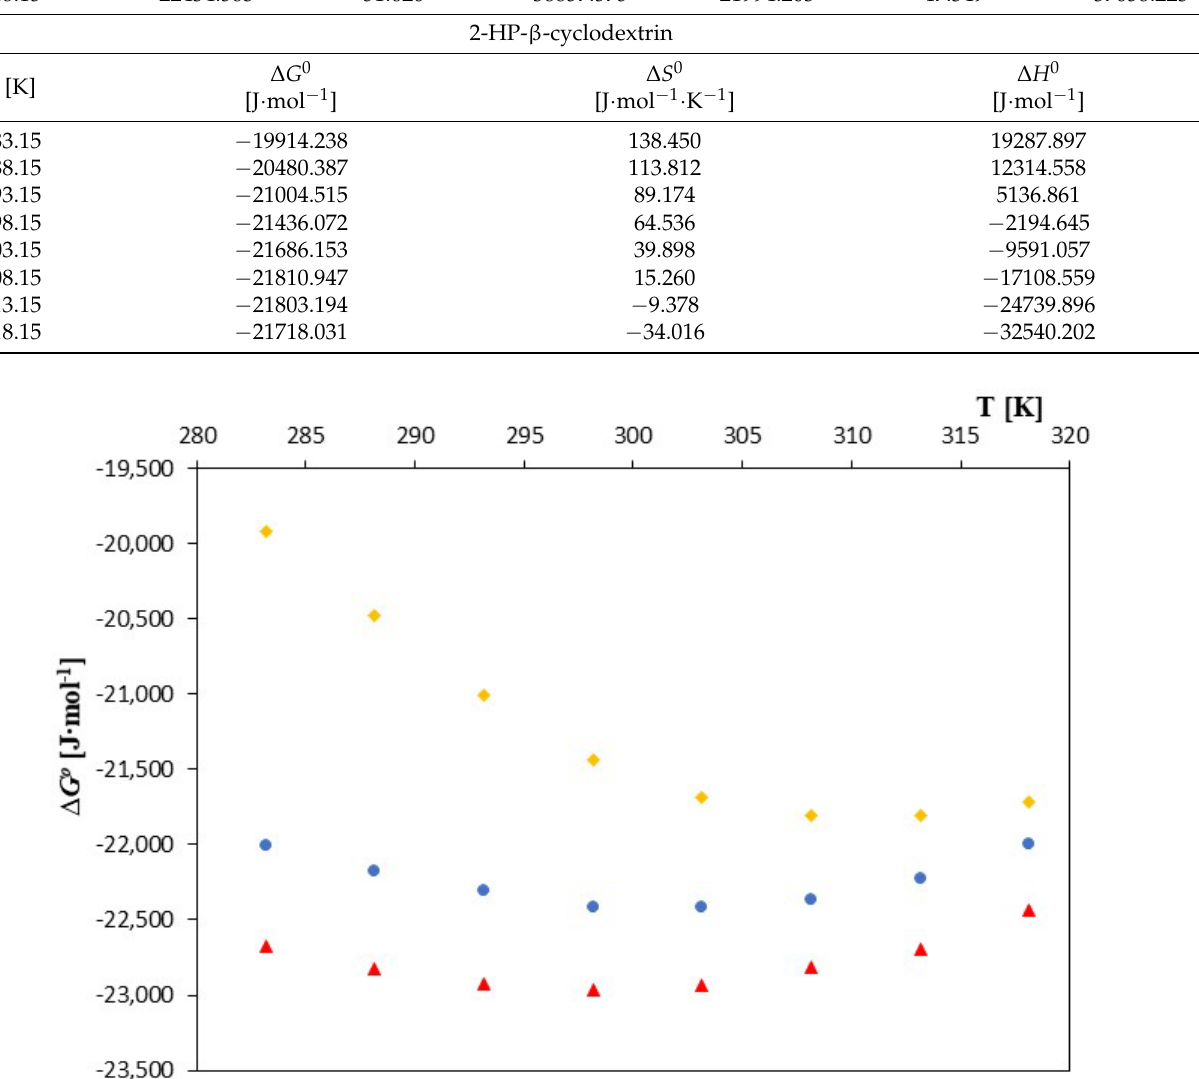
Figure 4. The plots of dependence ∆ G 0 [J · mol − 1 ] in the function T [K] for (cid:78) — α -cyclodextrin, • — β - cyclodextrin and (cid:7) —2-HP- β -cyclodextrin with all studied salt of dodecanoic